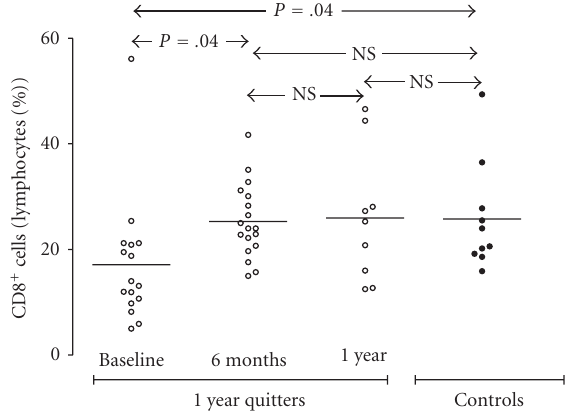
Figure 4: Percentage of sputum CD8 + T-cells (% sputum lympho- cytes) in “healthy” smokers before smoking cessation ( n = 16), after 6 months of smoking cessation ( n = 18), and after 1 year of smoking cessation ( n = 9). Results from 10 controls are also presented.